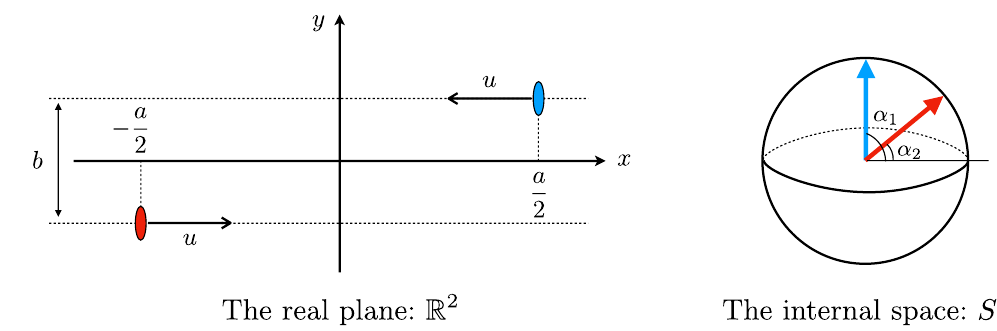
Figure 3 . Schematic picture of the initial state of two non-Abelian vortices. The left diagram shows the vortices in the real plane and the right the vortices in the internal plane. The painted ovals stand for the boosted vortices which are squashed because of the Lorentz contraction effect.